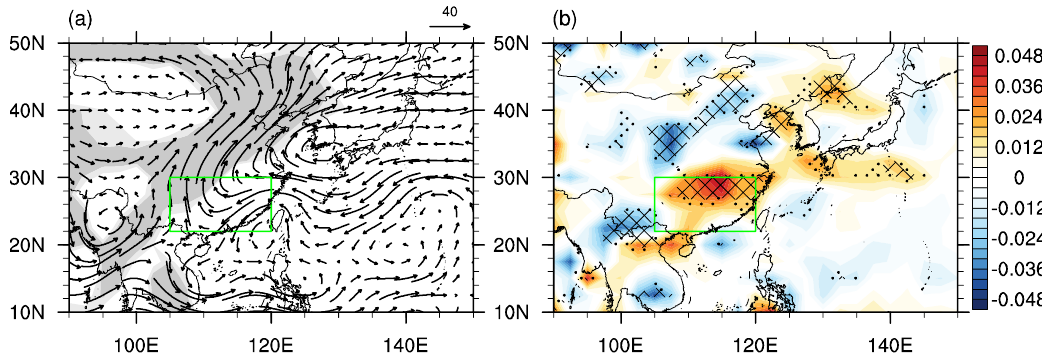
Figure 7. The differences in the summer mean ( a ) vertically integrated water vapor transport (vector, unit: kg m − 1 s − 1 ) and ( b ) divergence of the water vapor transport (unit: 10 − 3 kg m − 2 s − 1 ) between P2 and P1 (P2 minus P1). Light (dark) shadings in ( a ) and dots (meshes) in ( b ) denote where the anomalies are significant at the 90% (95%) confidence level based on Student's t -test. The green rectangle in ( a , b ) refers to the domain of southern China.